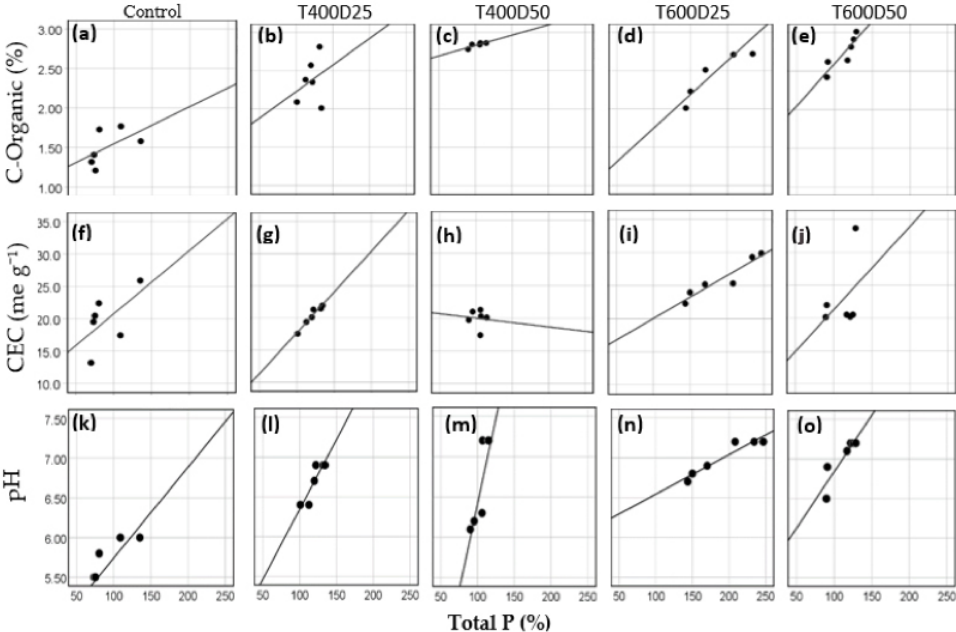
Figure 4. ( a – e ) correlation between Total P to organic-C, ( f – j ) CEC, and ( k – o ) pH in the five experi- mental treatments: dosage 0 t ha − 1 (control), dosage 25 t ha − 1 at 400 °C (D25T400), a dosage of 50 t ha − 1 at a temperature of 400 °C (D50T400), dosage 25 t ha − 1 at 600 °C (D25T600), and an amount of 50 t ha − 1 at a temperature of 600 °C (D50T600) after six months planted in the field. The line indicated the slope and form of correlation between the two parameters.